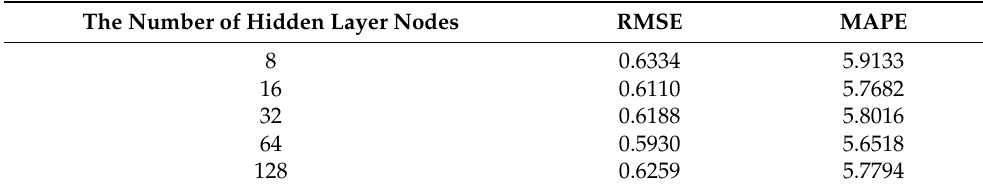
Table 3. Examples of prediction performance of different node sizes for the model (batch size = 32, lr = 0.001, L = 9).